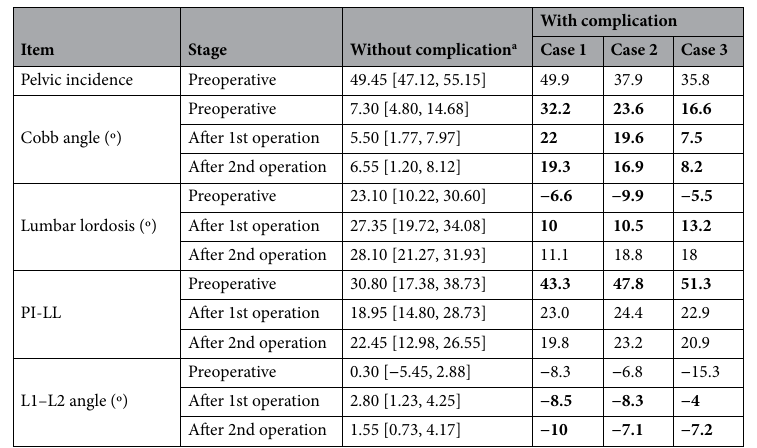
Table 3. Relationships between postoperative complications and changes in radiological parameters. Bold values indicate notable data. a Data are shown as median [interquartile range].